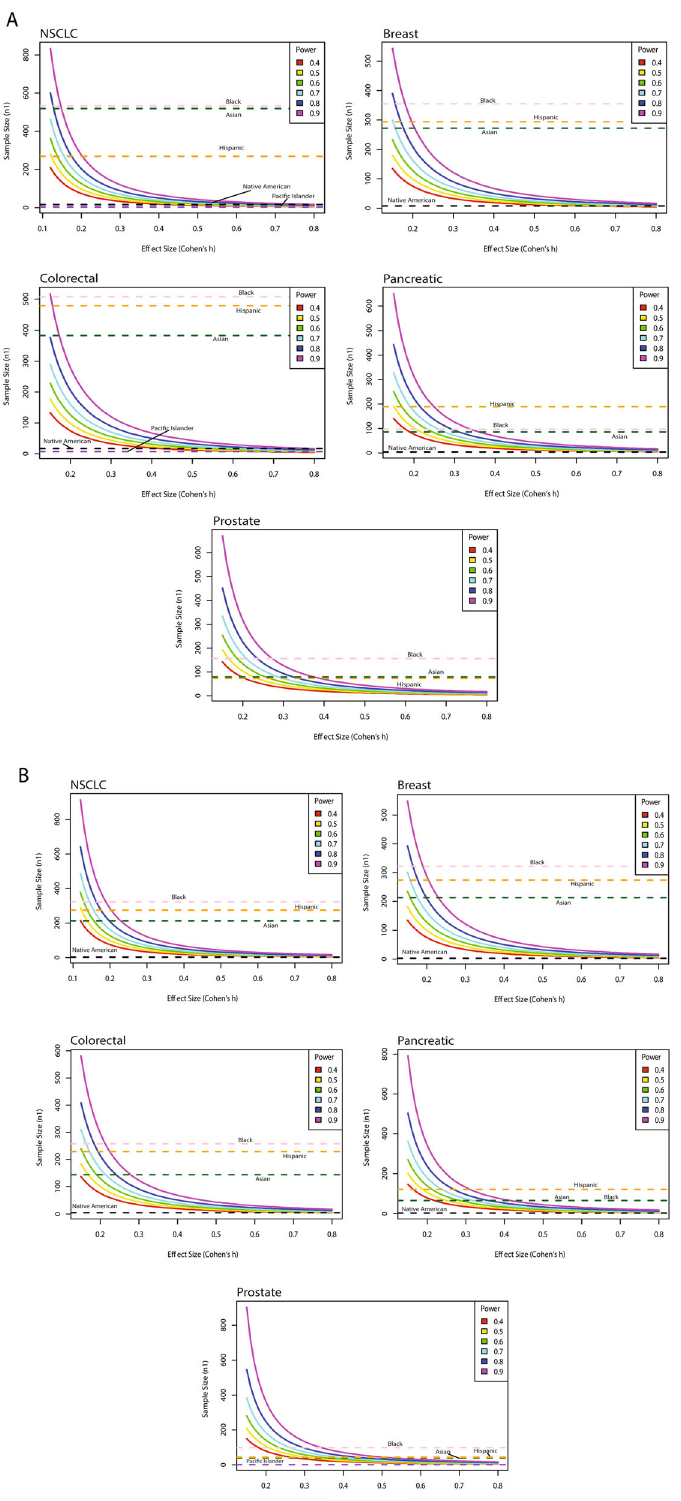
Fig. 2 Sample size estimation to detect differences in mutational proportions between white and racial/ethnic minority patients at varying power increments. Estimated number of samples (y-axis, n1) required to detect differences in mutational proportions between white and non-white patients at varying statistical power (solid curved lines) for different effect sizes (x-axis). All horizontal dashed lines indicate the current actual number of samples in GENIE for a given racial/ethnic group. Black (dashed pink), Hispanic (dashed orange), Asian (dashed dark green), Native American (dashed black), and Paci fi c Islander (dashed purple) racial/ethnic groups are displayed. Power = 0.8 is represented by the solid dark blue line. A Primary Cancer. B Metastatic